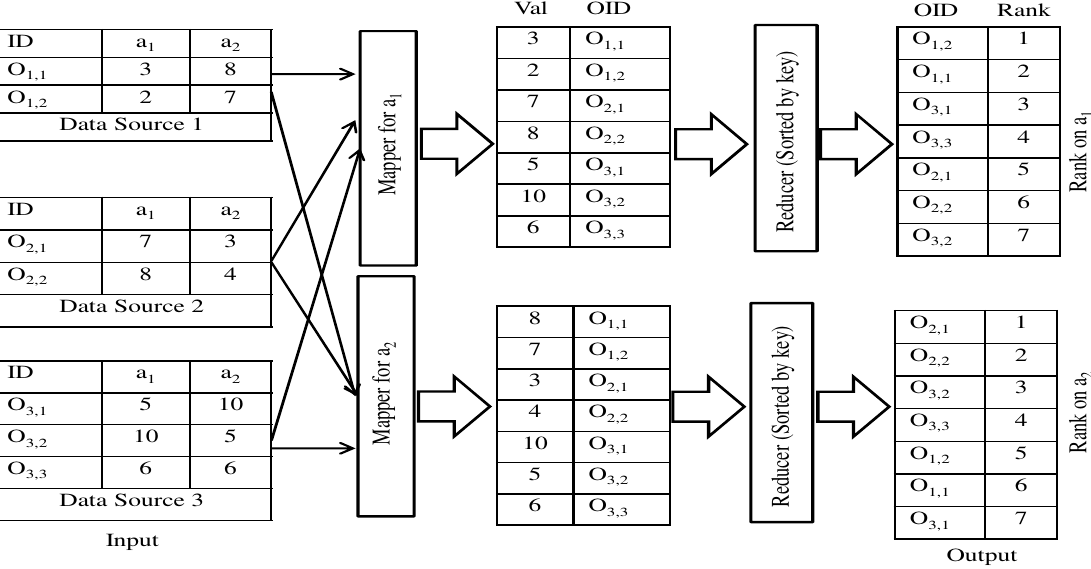
Figure 3. Data map and ranking process.